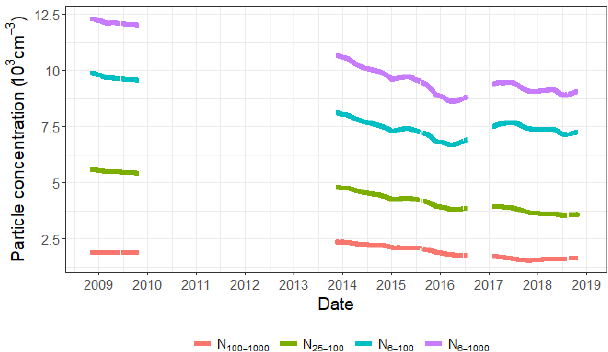
Figure 1. Statistical time trends of particle number concentrations in the diameter ranges from 6 to 1000nm ( N 6 − 1000 ), from 6 to 100nm ( N 6 − 100 ), from 25 to 100nm ( N 25 − 100 ) and from 100 to 1000nm ( N 100 − 1000 ) derived by DLM over a decennial